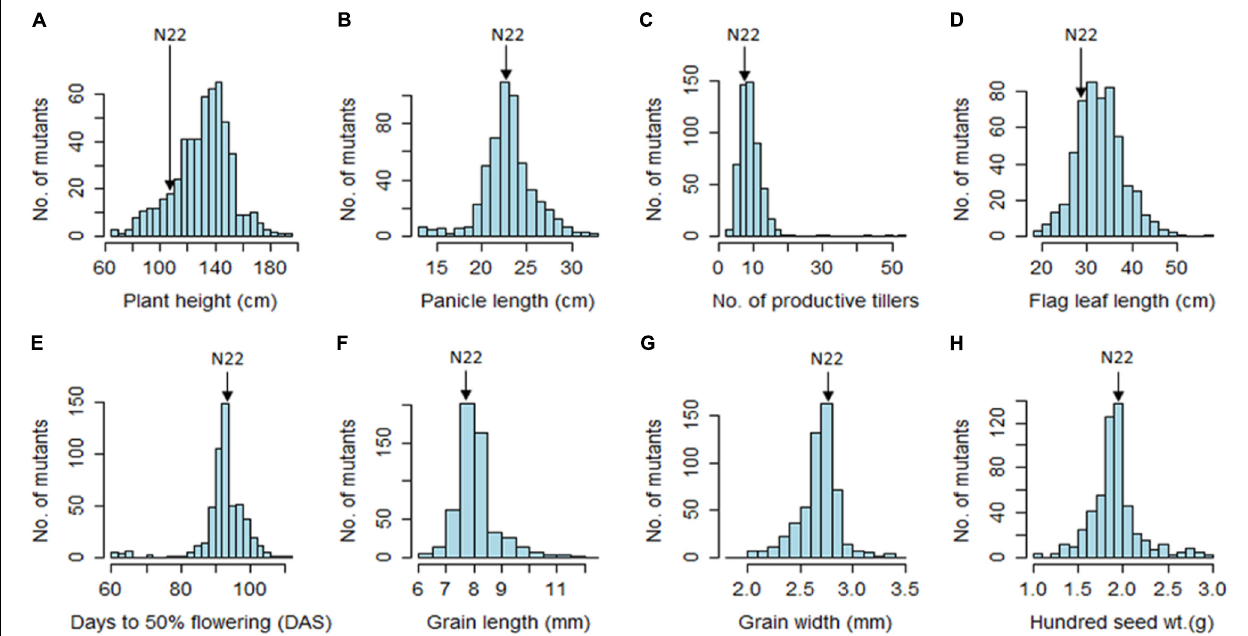
FIGURE 1 | Frequency distribution of 541 rice EMS mutants of Nagina 22 for major morphological traits. (A) Plant height; (B) panicle length; (C) number of productive tillers; (D) flag leaf length; (E) days to 50% flowering; (F) grain length; (G) grain width; (H) hundred seed weight. Unit of the traits measured are indicated in the parenthesis in the